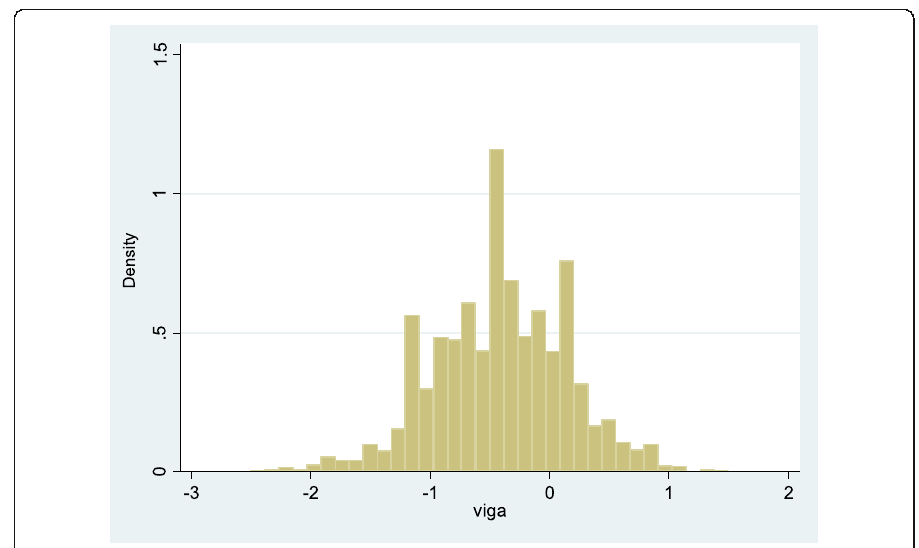
Fig. 6 Distribution of individual reporting heterogeneity from vignette set A. Note: health domains in set A includes mobility and affect